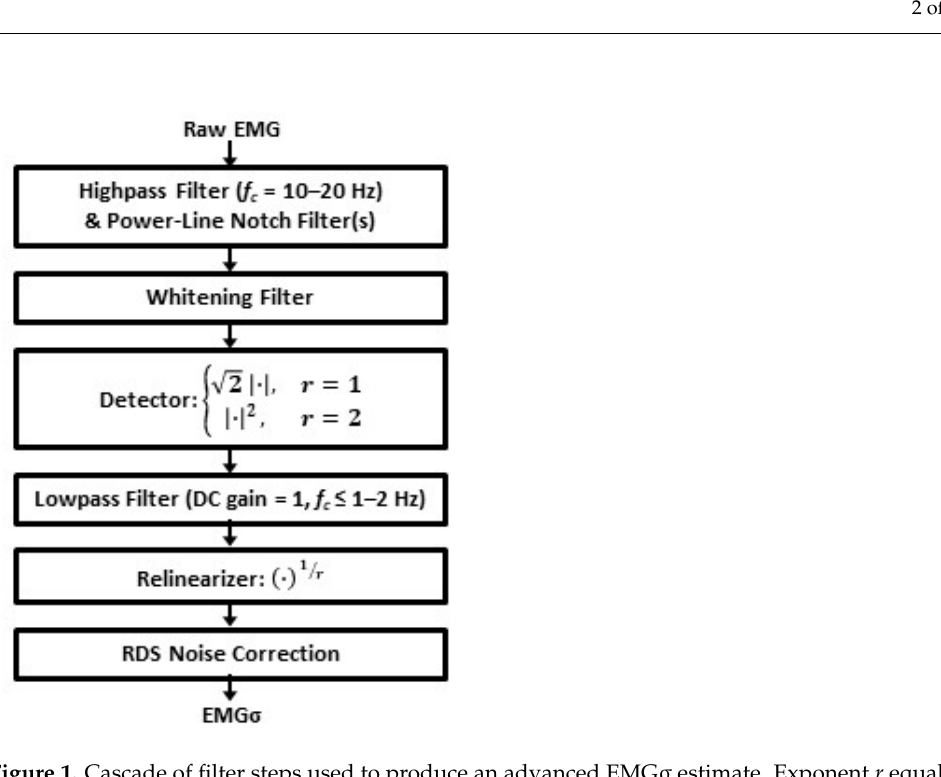
Figure 1. Cascade of filter steps used to produce an advanced EMG σ estimate. Exponent r equals 1 or 2. RDS = root difference of squares.